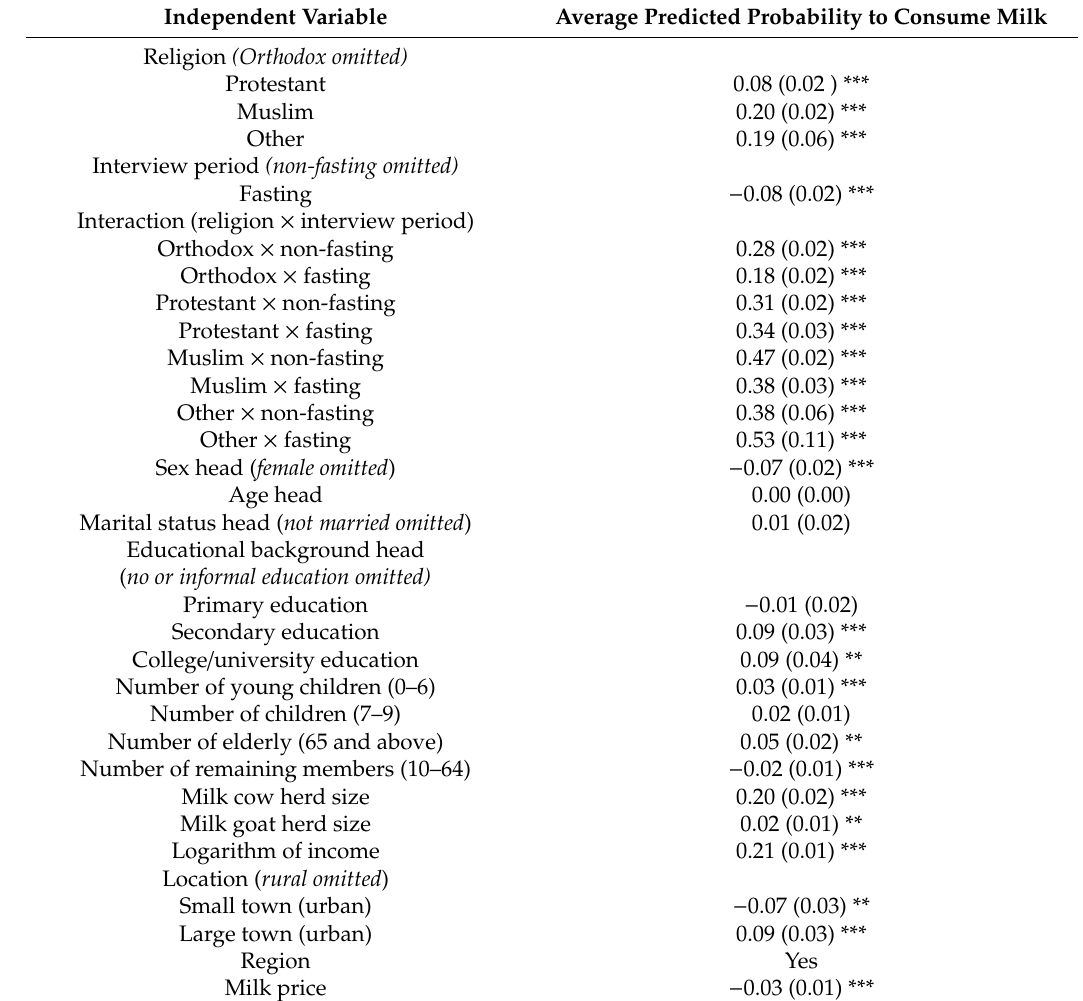
Table 3. Predicted probability to consume milk at the household level evaluated at the mean of the